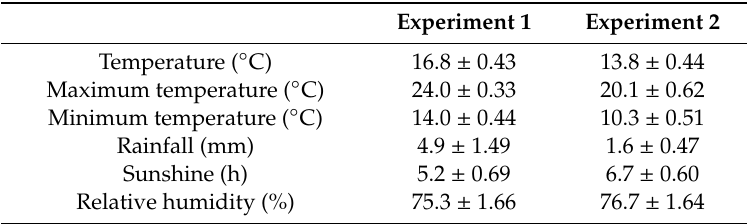
Table 9. Mean environmental conditions ( ± standard error of the mean) in field experiment 1 and